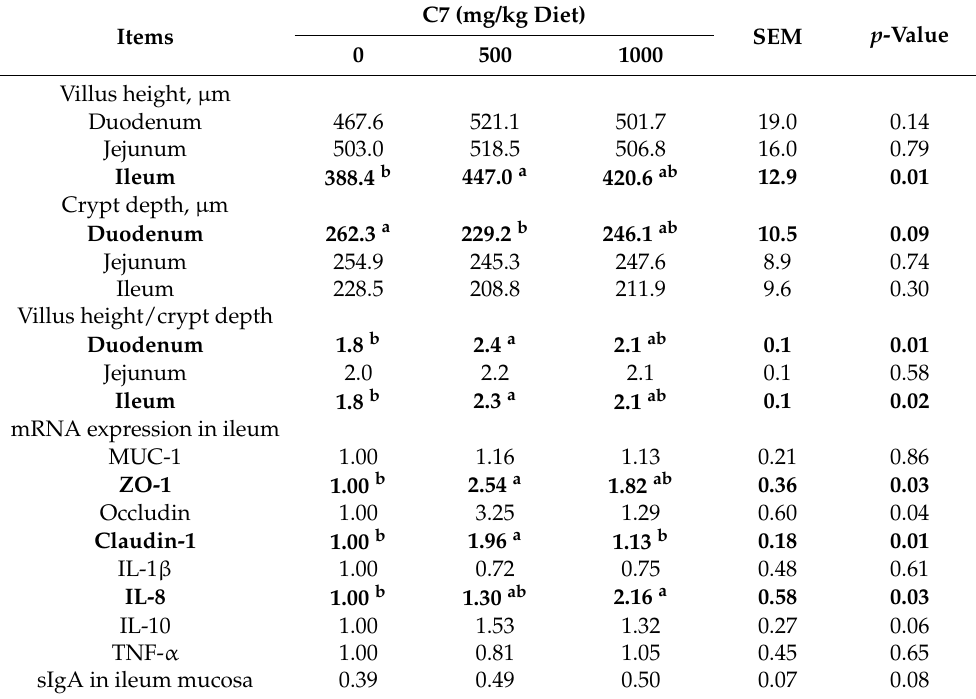
Table 11. Effect of dietary C7 supplementation on intestinal health